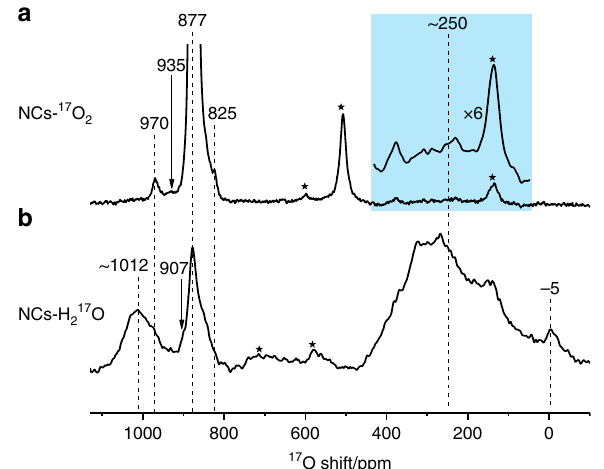
Fig. 1 17 O Solid-State NMR spectra of ceria nanocubes. The 17 O NMR measurements were performed at a spinning speed of 20 kHz for NCs- 17 O 2 ( a ) and 16 kHz for NCs-H 2 17 O ( b ). A rotor synchronized Hahn-echo pulse sequence ( π /6- τ - π /3- τ -acquisition) with 1 H decoupling and a 0.5 s recycle delay was used. Stars denote spinning sidebands. In order to show the peaks due to OH better, a line broadening of 600 Hz is applied for the enlarged spectrum shown in light blue the concentration of oxygen vacancies at the surface is only 1.0%